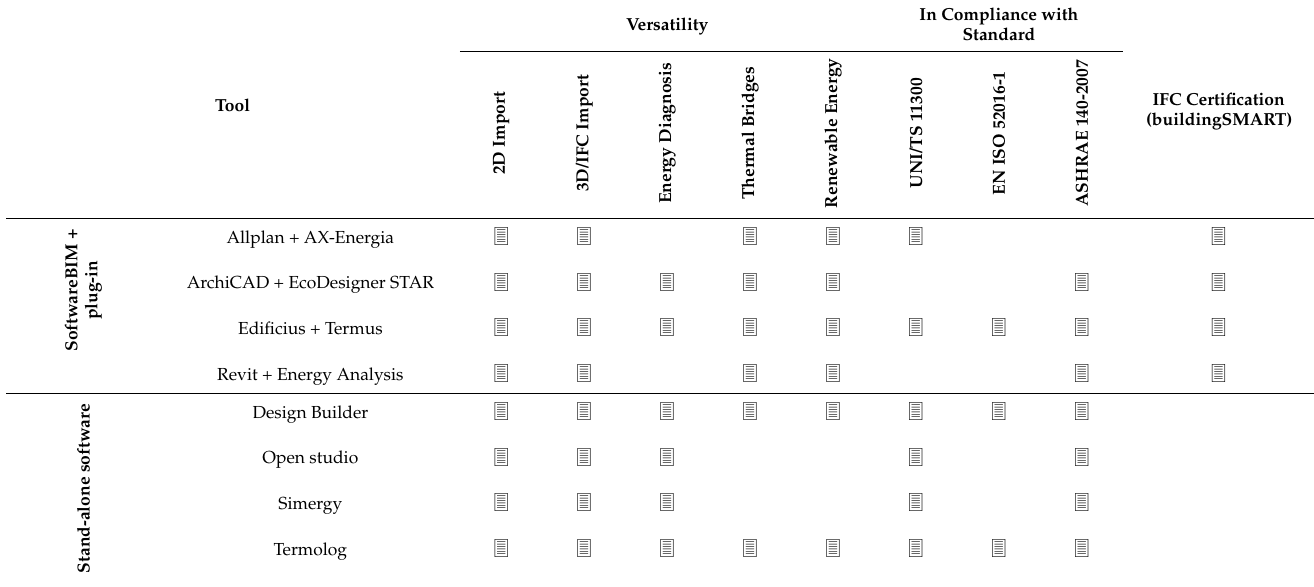
Table 1. Comparison of eight examined tools.